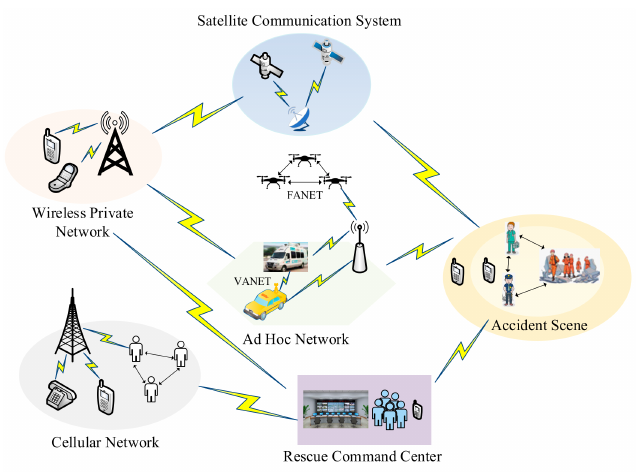
Figure 13. Collaborative network